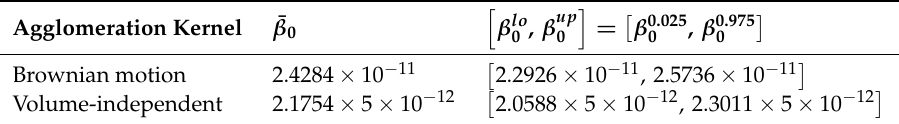
Figure 9. Results for parameter estimation for volume-independent agglomeration kernel with parametric bootstrap data: Histogram of bootstrapped parameter set, confidence interval (red circles) and mean ¯ β 0 (red rectangle) ( Left ) Change of number of bootstrap runs ( Right ). Table 4. Mean parameter values and confidence intervals from parametric